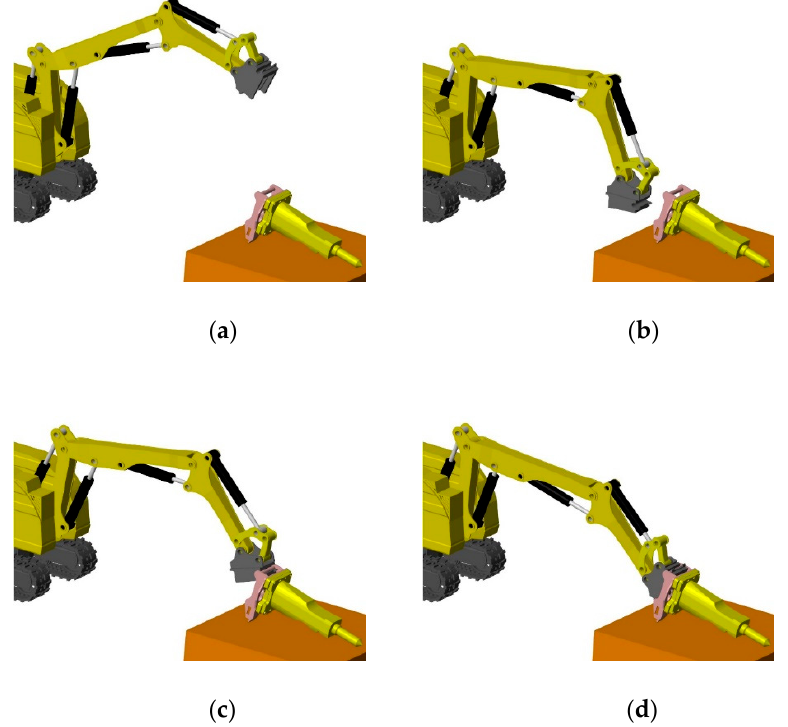
Figure 1. Attachment changing procedure: ( a ) initialization, ( b ) preparation, ( c ) range alignment, and ( d ) angle alignment.